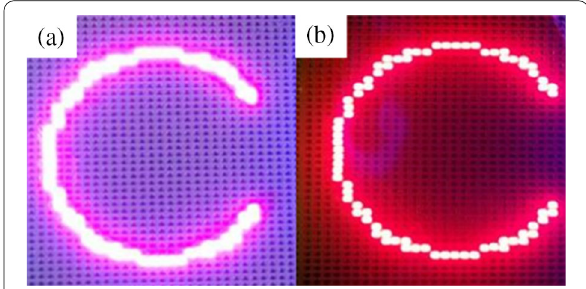
Fig. 14 Red QDs sample a before and b after addition of RCPEF